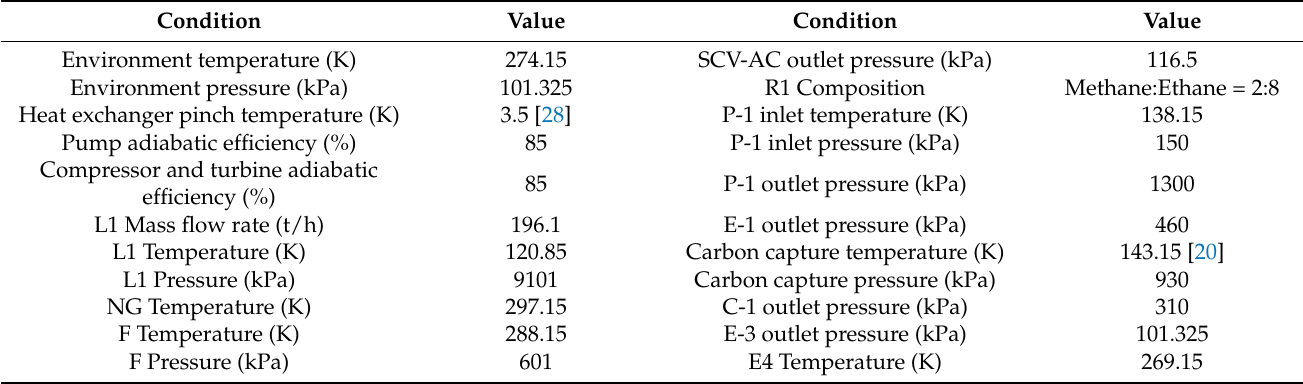
Table 3. Initial simulation conditions for System A and System